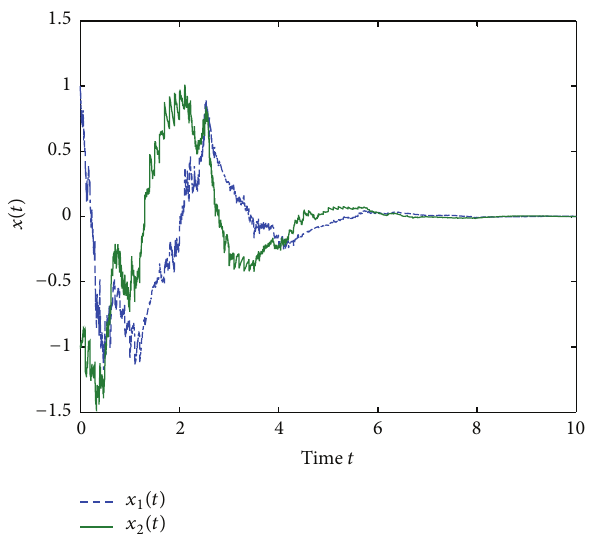
Figure 4: The state trajectory of the system without external input (single